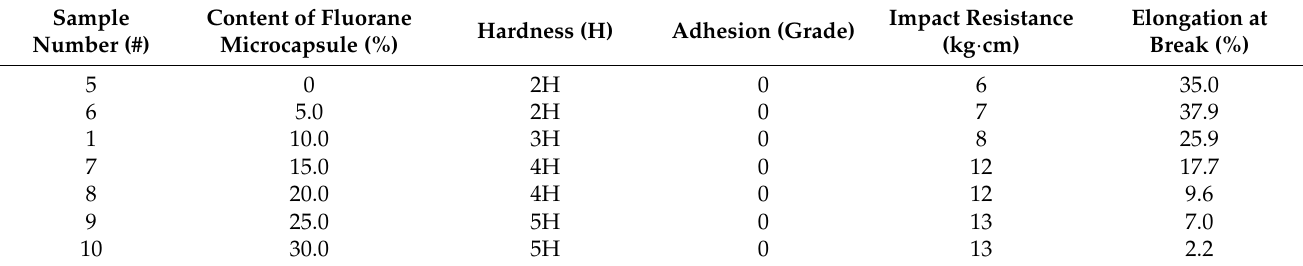
Table 4. Effect of microcapsule concentration on mechanical properties.